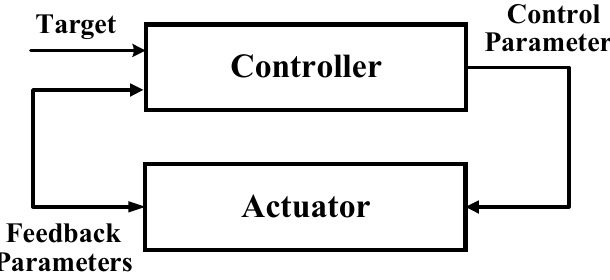
Figure 21. Block diagram of the control system.